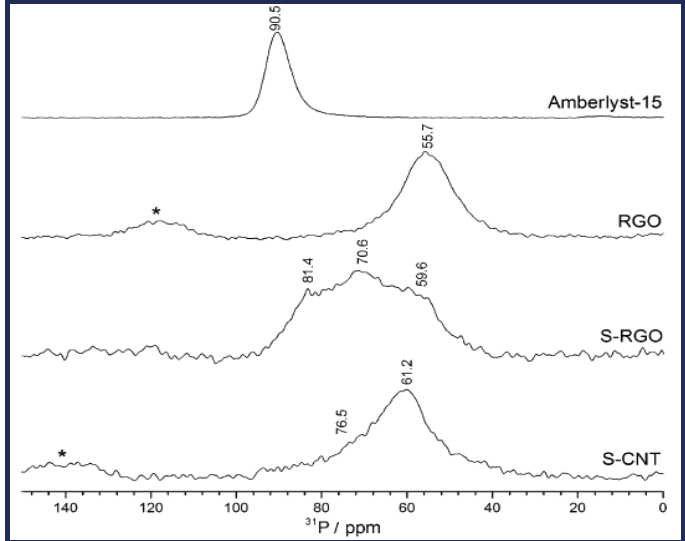
Figure 4. The 31 P MAS NMR spectra of TEPO adsorbed onto carbocatalysts and Amberlyst-15. Reproduced with permission from [89]. Copyright (2014) Wiley-VCH Verlag GmbH &